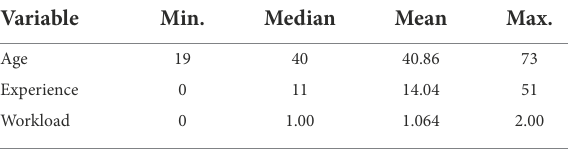
TABLE 2 Descriptive statistics for continuous variables ( n = 3,029).